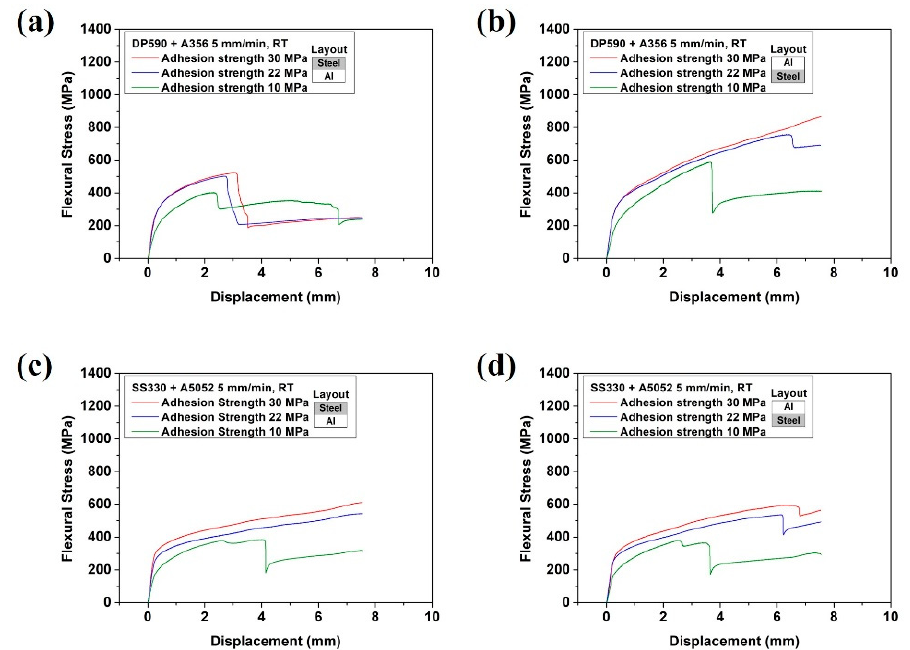
Figure 7. Flexural stress–displacement curves of both multi-materials with different adhesion strengths: ( a ) DP590 (upper)–A356 (lower), ( b ) DP590 (lower)–A356 (upper), ( c ) SS330 (upper)– A5052 (lower), and ( d ) SS330 (lower)–A5052 (upper).